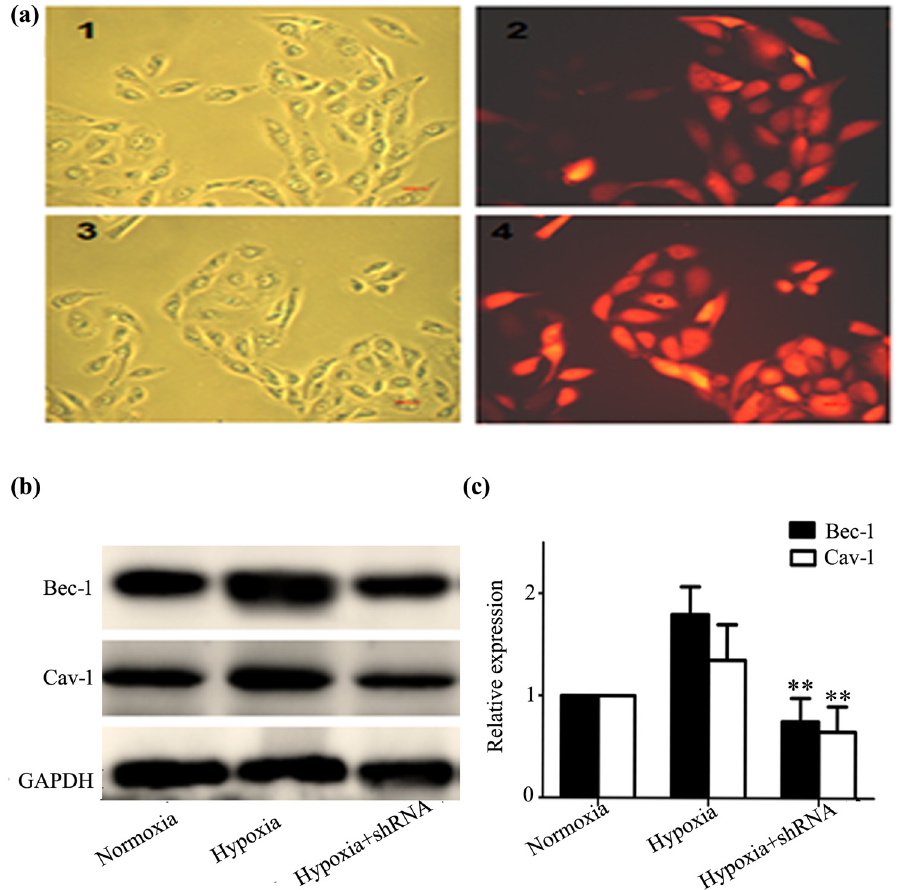
Figure 5: Suppression of Cav - 1 by shRNA or Bec - 1 by shRNA in hypoxia - treated cells. ( a ) ( 1 ) HK - 2 cells ( control ) , ( 2 ) Bec - 1 shRNA lentiviral vector was infected into HK - 2 cells. ( 3 ) HK - 2 cells ( control ) , ( 4 ) Cav - 1shRNA lentiviral vector was infected into HK - 2 cells. The success rate of infection was almost accounted for 100%. ( b ) Cav - 1 and Bec - 1 expression were suppressed in shRNA infected cells. Downregulated Cav - 1 and Bec - 1 expression in HK - 2 cells under hypoxia or normoxia were detected by western blot. Cav - 1 and Bec - 1 expression levels were suppressed in protein levels when compared with the non - shRNA group in hypoxia. ( c ) Expression levels of Cav - 1 and Bec - 1 relative to that of GAPDH. Error bars represented mean ± SD, and the results were analyzed by unpaired with Student ’ s t - test, * p < 0.05, ** p <